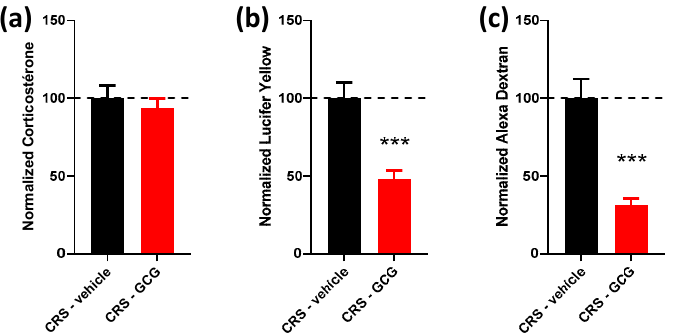
Figure 3. Effect of combined selected compounds, glutamine, Curcuméga ® and Gabolysat ® (GCG), on plasma corticosterone levels and colonic permeability. Corticosterone levels ( a ) measured in plasma and Lucifer yellow ( b ) and Alexa Dextran ( c ) concentrations measured in Ussing chambers in the CRS-vehicle (black bars) vs. CRS-GCG group (red bars). n = 10–19 per group. Data are presented as means ± SEM. ***, p < 0.001, Student’s t -test. Dashed line represents the level observed in untreated CRS mice.